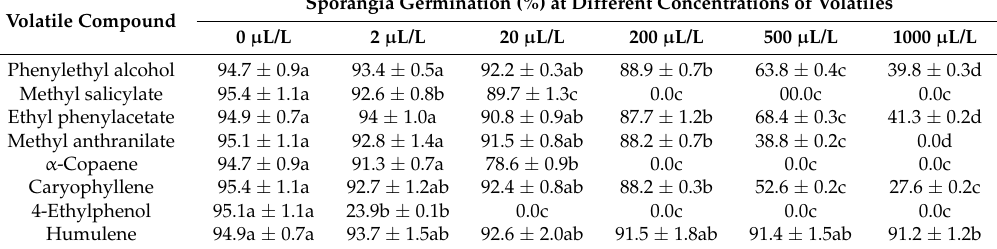
Table 7. Effect of volatile compounds on P. litchii sporangia